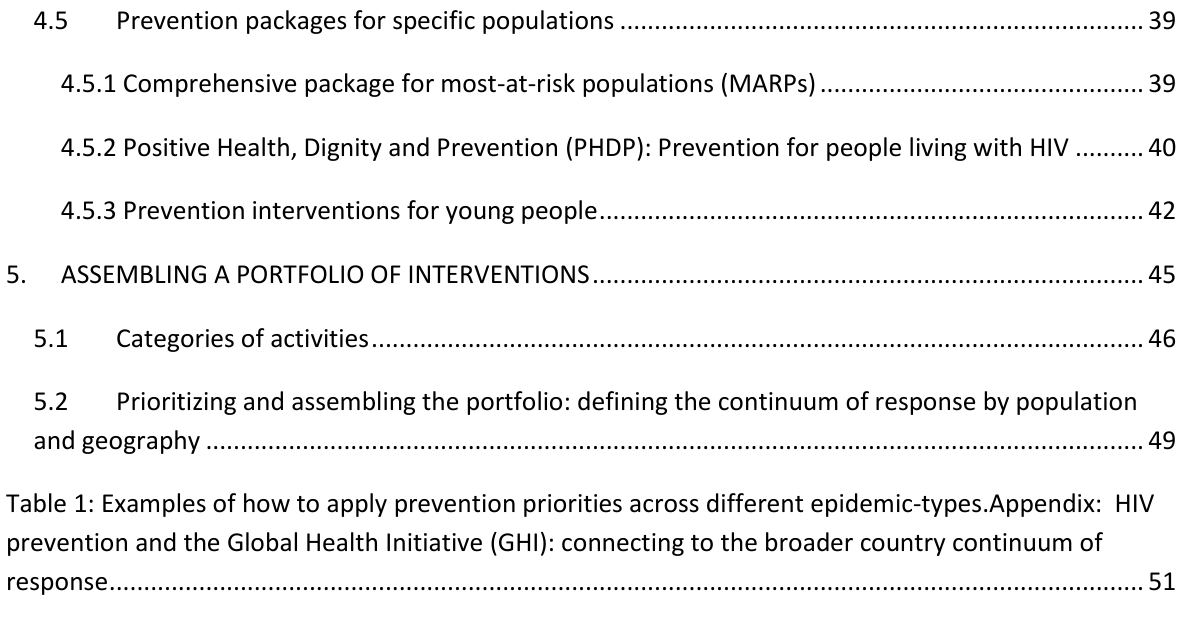
Appendix: HIV prevention and the Global Health Initiative (GHI): connecting to the broader